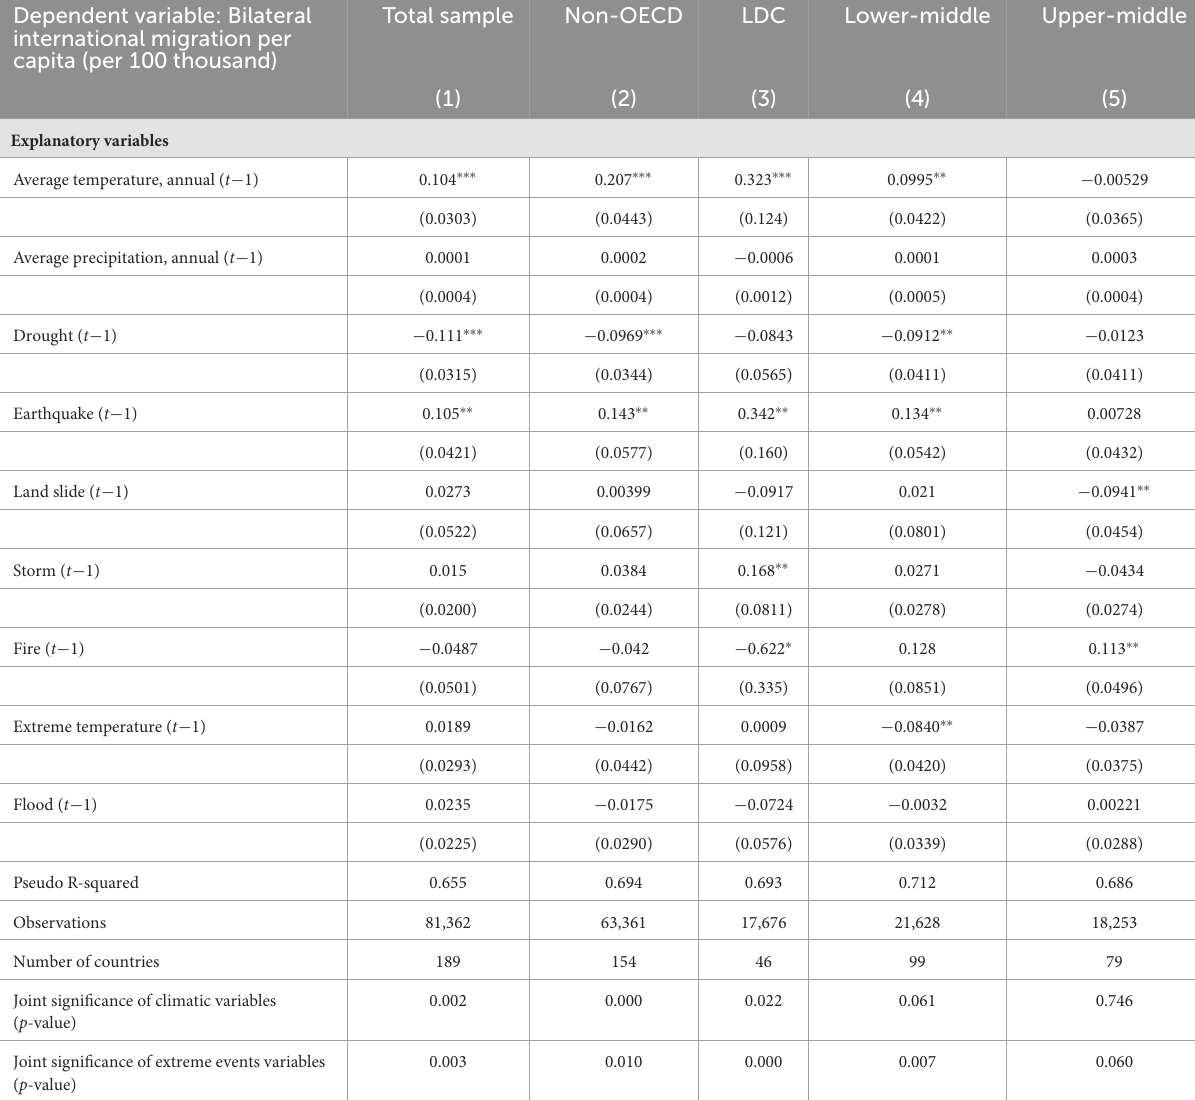
TABLE 2 Main results: The impact of climatic events on out-migration by economic sub-samples. Dependent variable: Bilateral international migration per capita (per 100